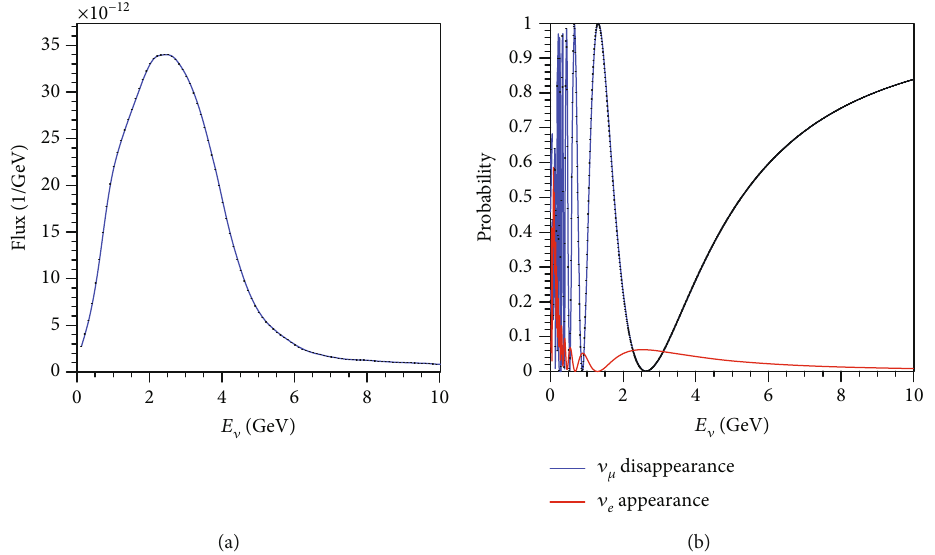
Figure 1: Flux distribution in the energy regime 0.1-10GeV and neutrino-oscillation probability presented in the (a) and (b),